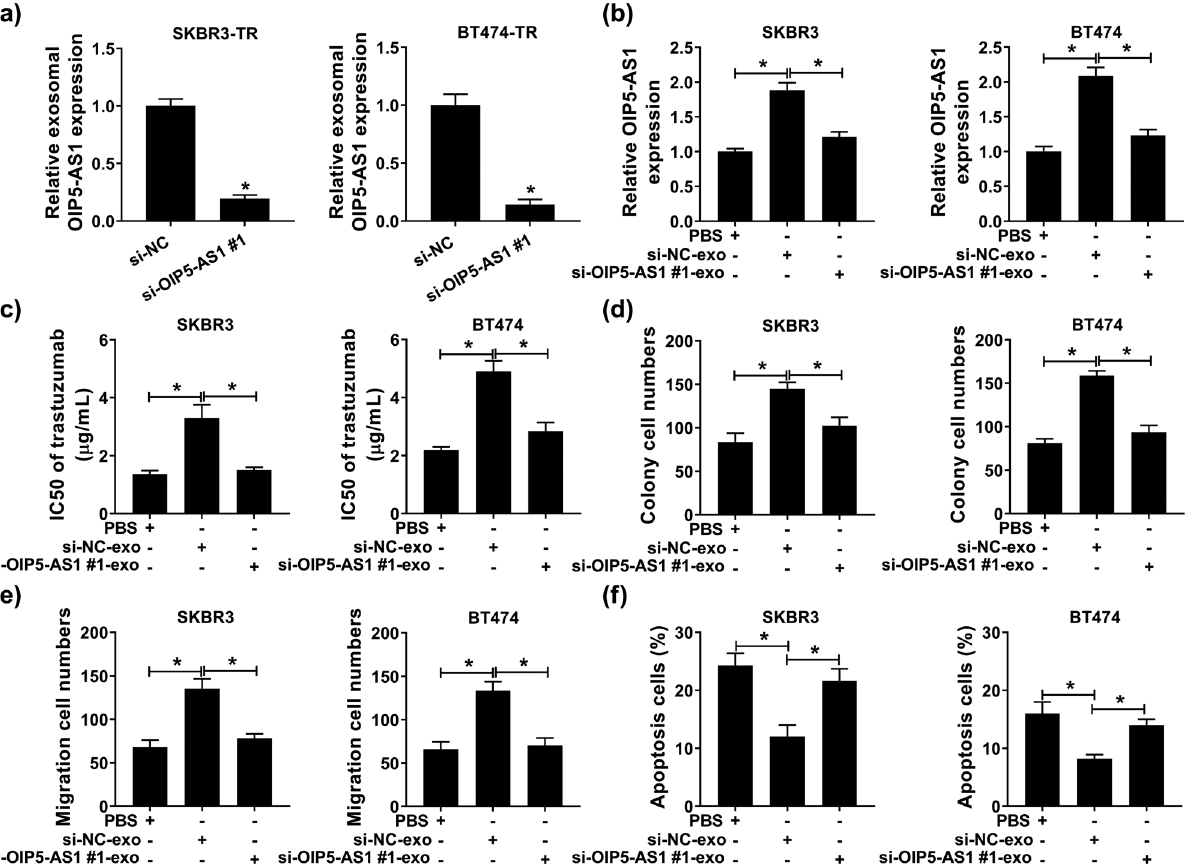
Figure 4: Intercellular transfer of OIP5 - AS1 by exosomes enhances trastuzumab resistance in vitro. ( a ) qPCR analysis of OIP5 - AS1 expression in exosomes isolated from SKBR3 - TR and BT474 - TR cells transfected with si - OIP5 - AS1#1 or si - NC. SKBR3 and BT474 cells were co - cultured with exosome - depletion PBS, si - OIP5 - AS1#1 - exo, or si - NC - exo. After incubation; ( b ) levels of OIP5 - AS1 were detected with qPCR; ( c ) CCK - 8 analysis of IC 50 values of parental cells to trastuzumab; ( d ) colony formation analysis of parental cell proliferation; ( e ) migration analysis of parental cells using transwell assay; ( f ) fl ow cytometry assay for parental cell apoptosis. * P <